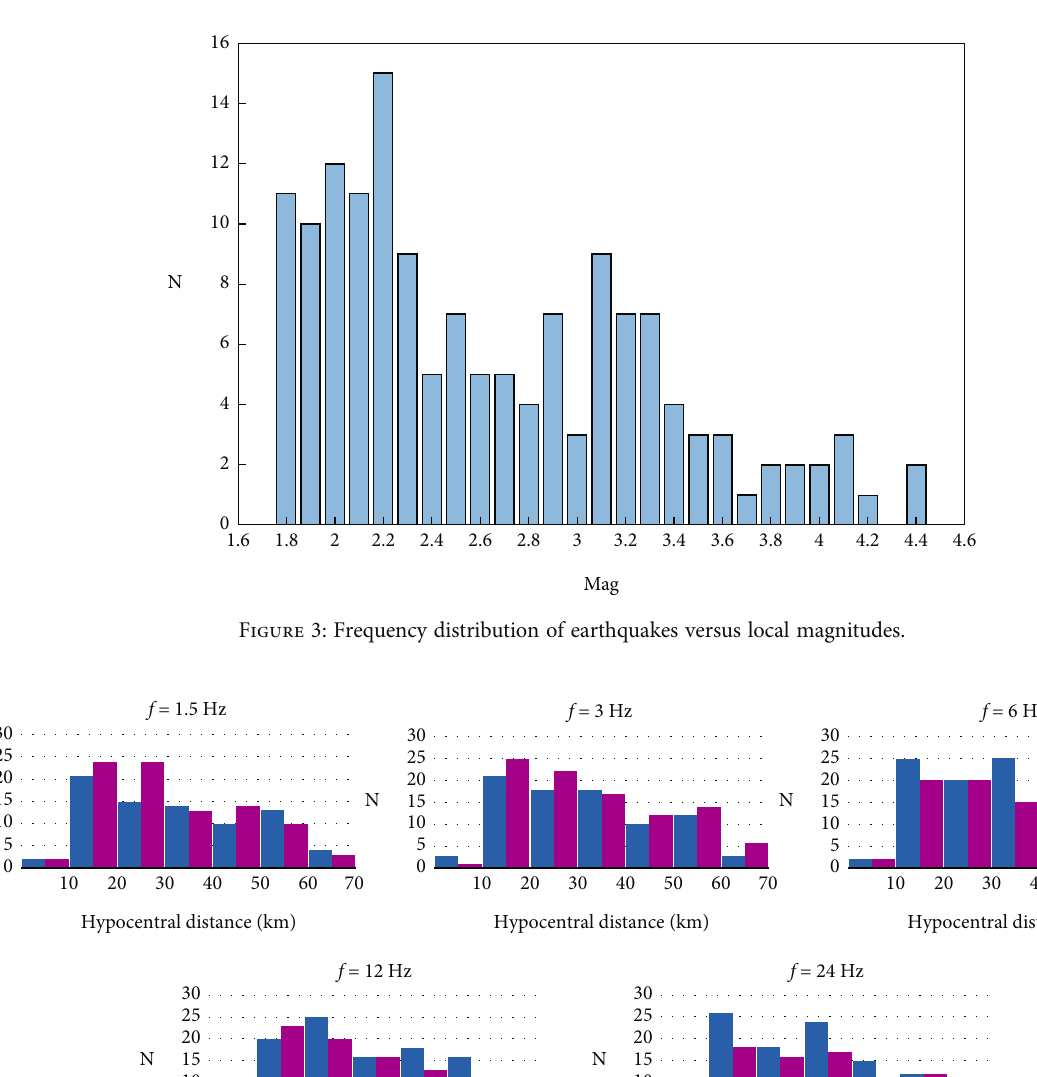
and Q at di ff erent central p s